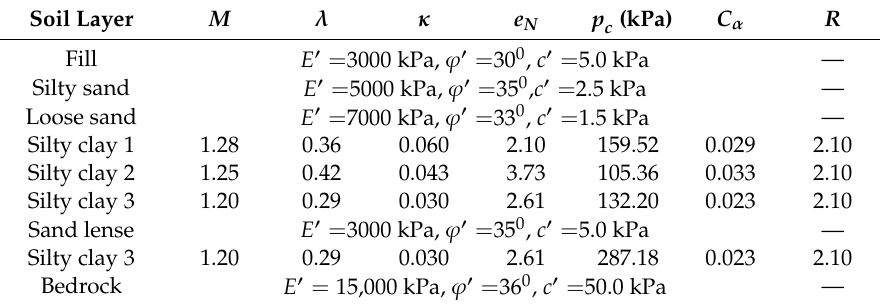
Figure 14. Comparison of observed and predicted settlement response of the Nerang Broadbeach Roadway embankment’s surcharge-preloading. 6. Conclusions In this paper, we presented a non-associated flow rule (NAFR)-based three surfaces elasto- viscoplastic model. Assuming the potential surface and the reference surface are identical, the NAFR S e ttl e m e n t ( mm )